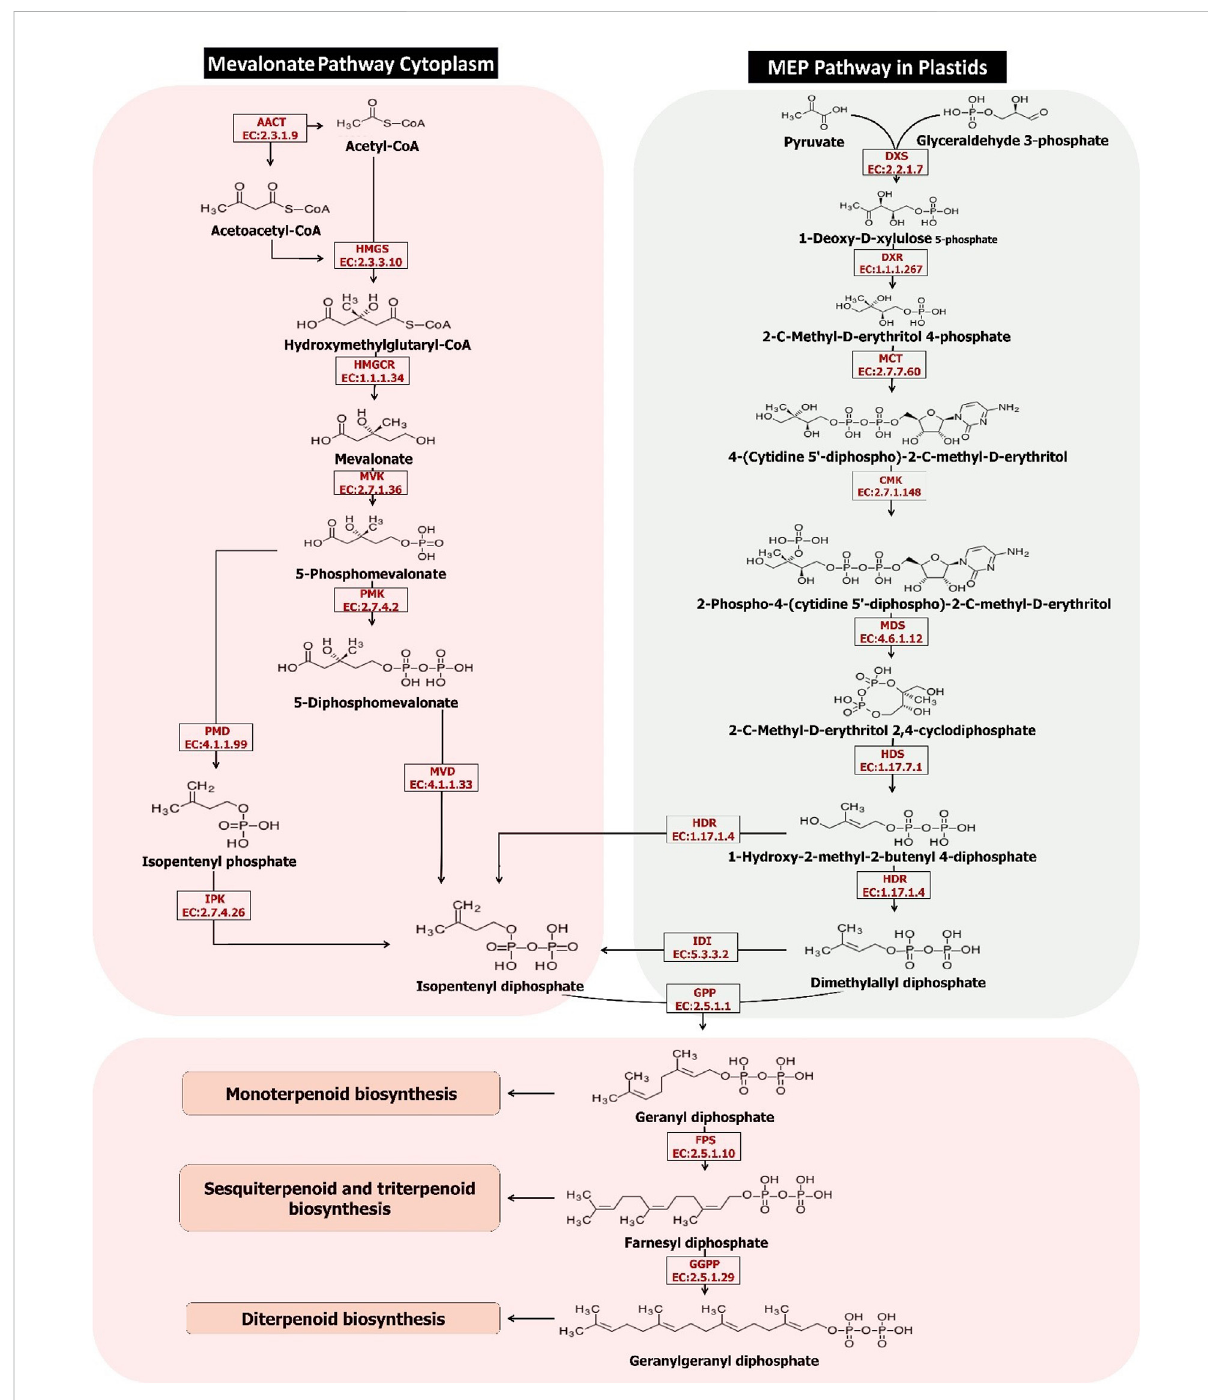
FIGURE 2 The terpenoids biosynthesis pathways in the Oliveria decumbens